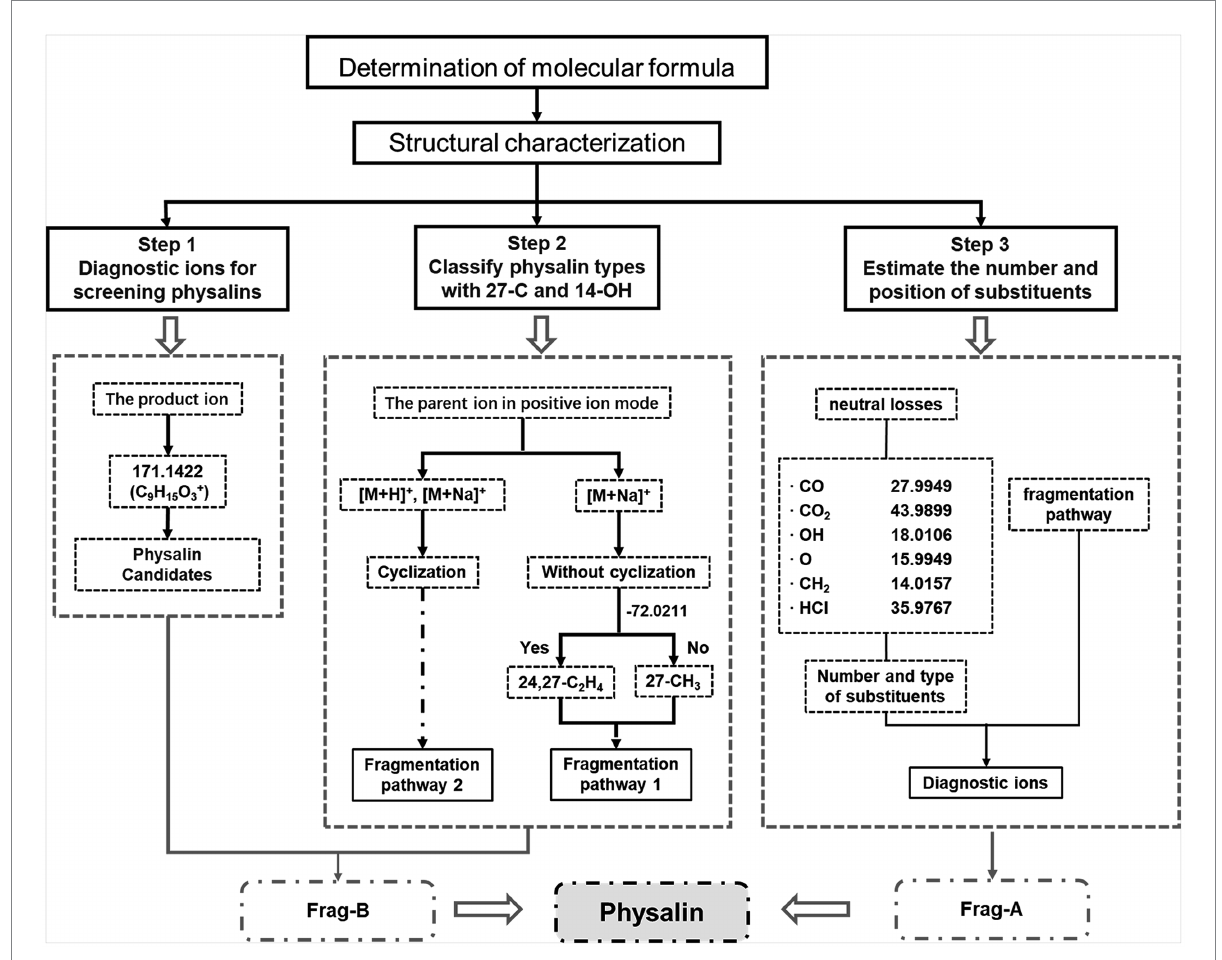
FIGURE 4 Data mining strategies for rapid discovery and characterization of physalins. Three key steps were developed for efficient characterization of non- targeted physalins using these strategies. (1) Initial screening of physalins using diagnostic ions. (2) Structure determination with 27-C and 14-OH. (3) Get feature information of the